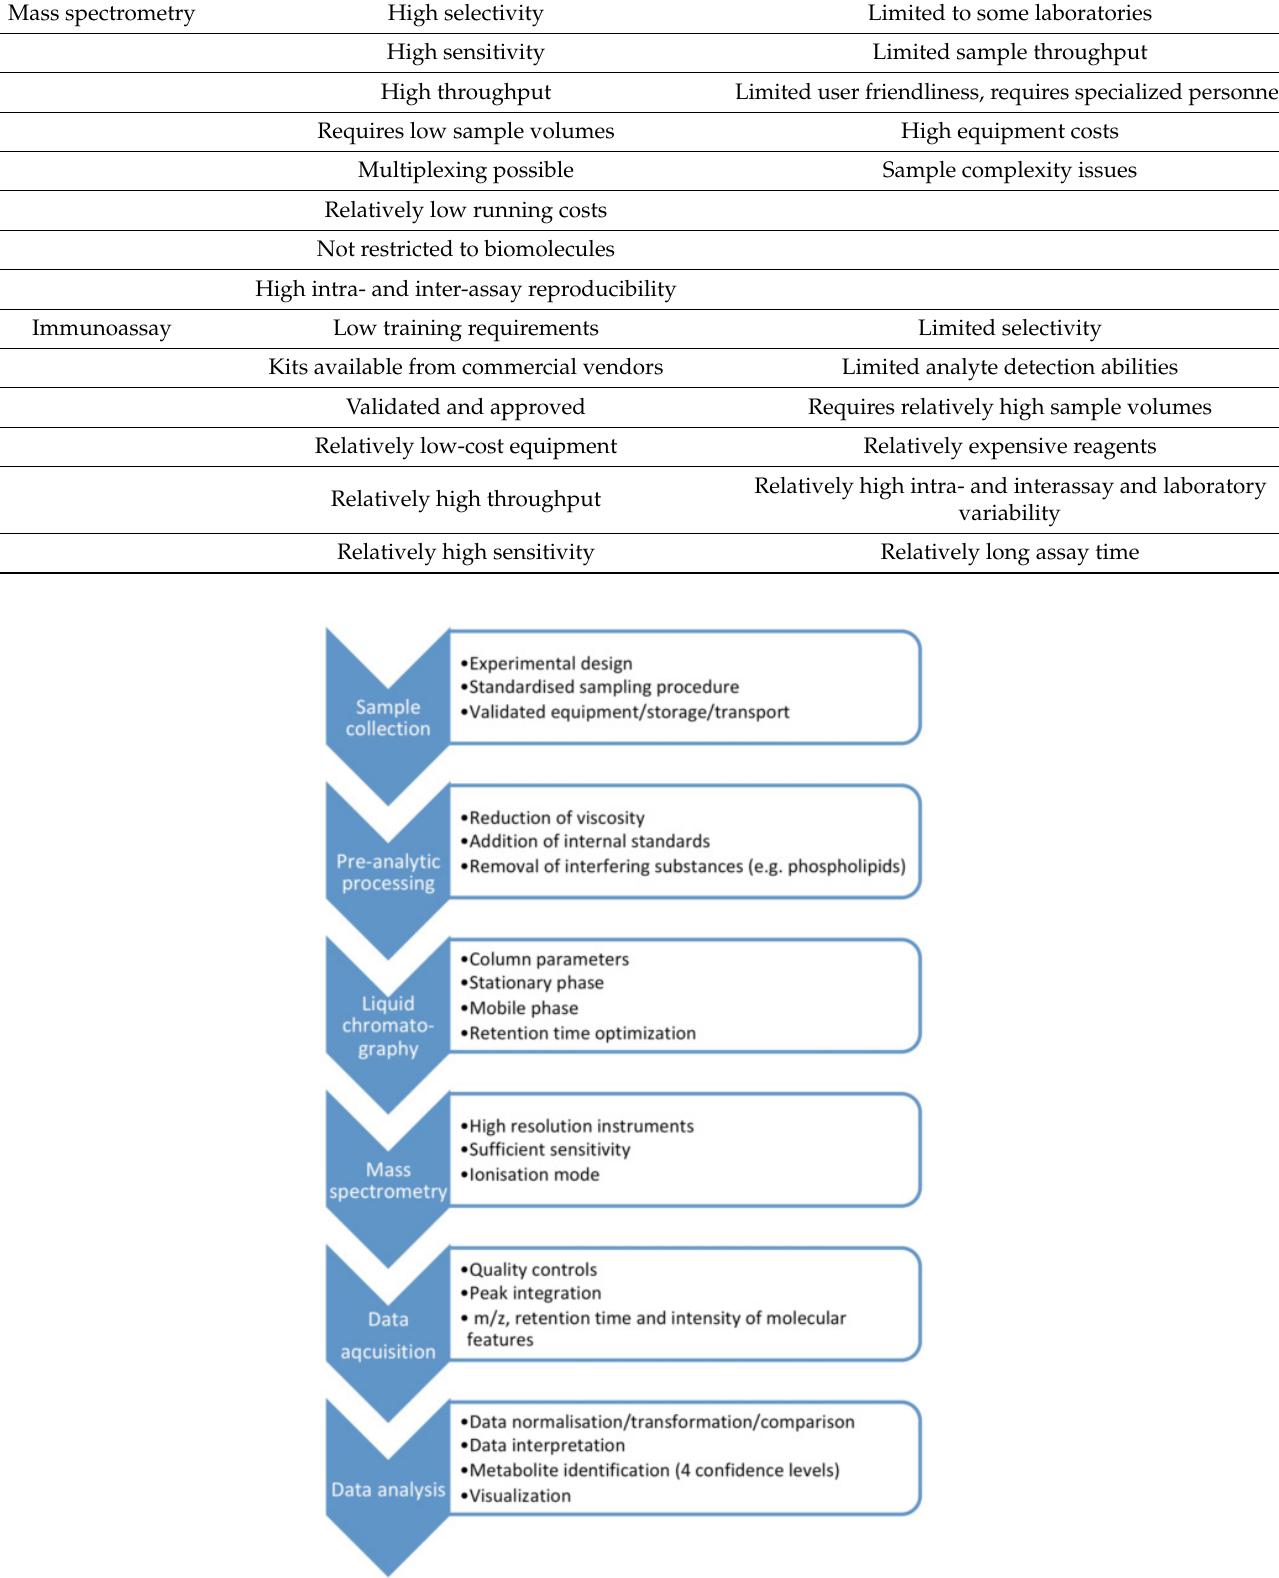
Figure 1. The metabolomics mass spectrometry workflow for biofluids including Table 1. Advantages and disadvantages of mass spectrometry-based assays and immunoassays [14] . ethod